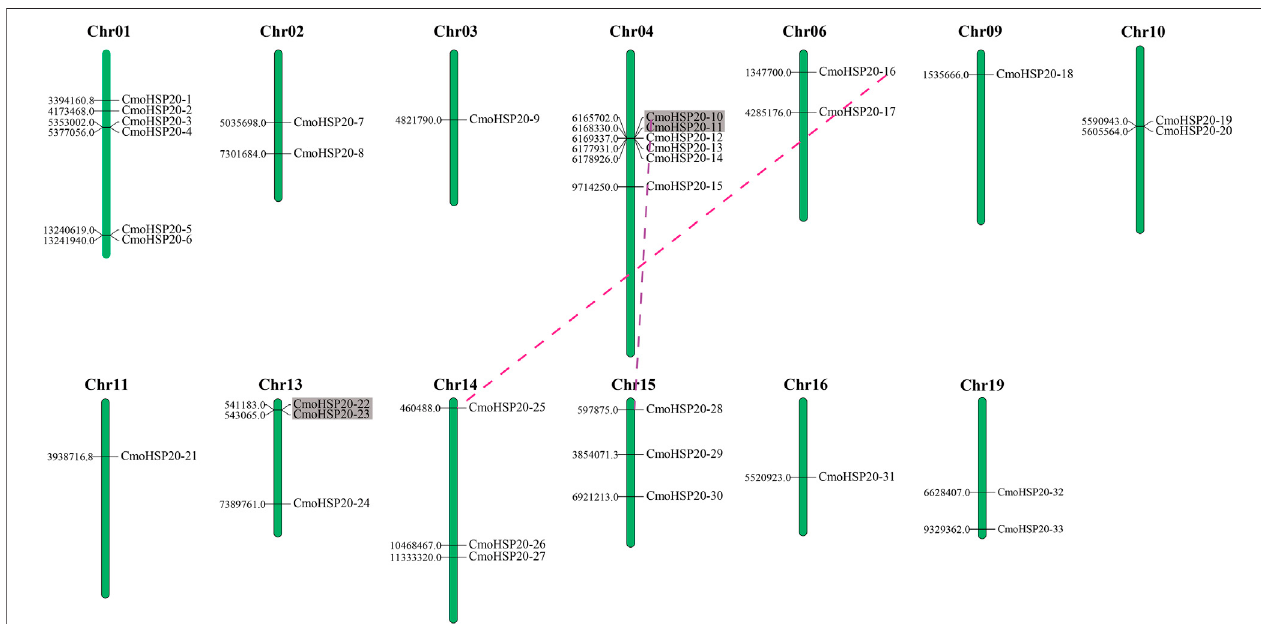
FIGURE 5 | Chromosomal location and gene duplication events in CmoHSP20s . The chromosome number is listed at the top of each chromosome while the numbertotheleftofeachchromosomerepresentsthelocationofthe CmoHSP20 geneontheright.Onlythechromosomeswhere CmoHSP20 genesweremappedare shown. The tandem duplicated genes are marked by grey rectangles and the segmental duplicated genes are linked by colored dotted